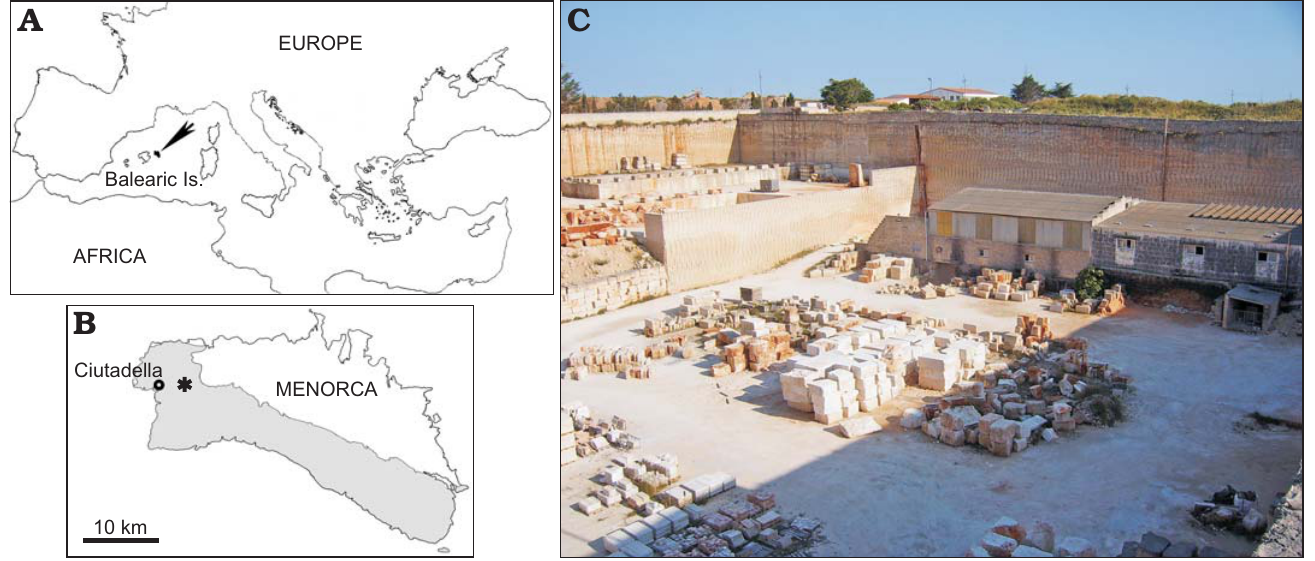
Fig. 1. A . Geographical location of Menorca in the Mediterranean Sea (black arrow). B . Close-up of Menorca showing location of the Son Salord quarry (asterisk), where the Messapicetus MDM-2029 was found. The grey area indicates the extent of the upper Miocene (Tortonian–Messinian) carbonate deposits cropping out on the island. C . General view of the Son Salord quarry. The floor of the quarry roughly corresponds to the stratigraphic level where the fossil beaked whale was